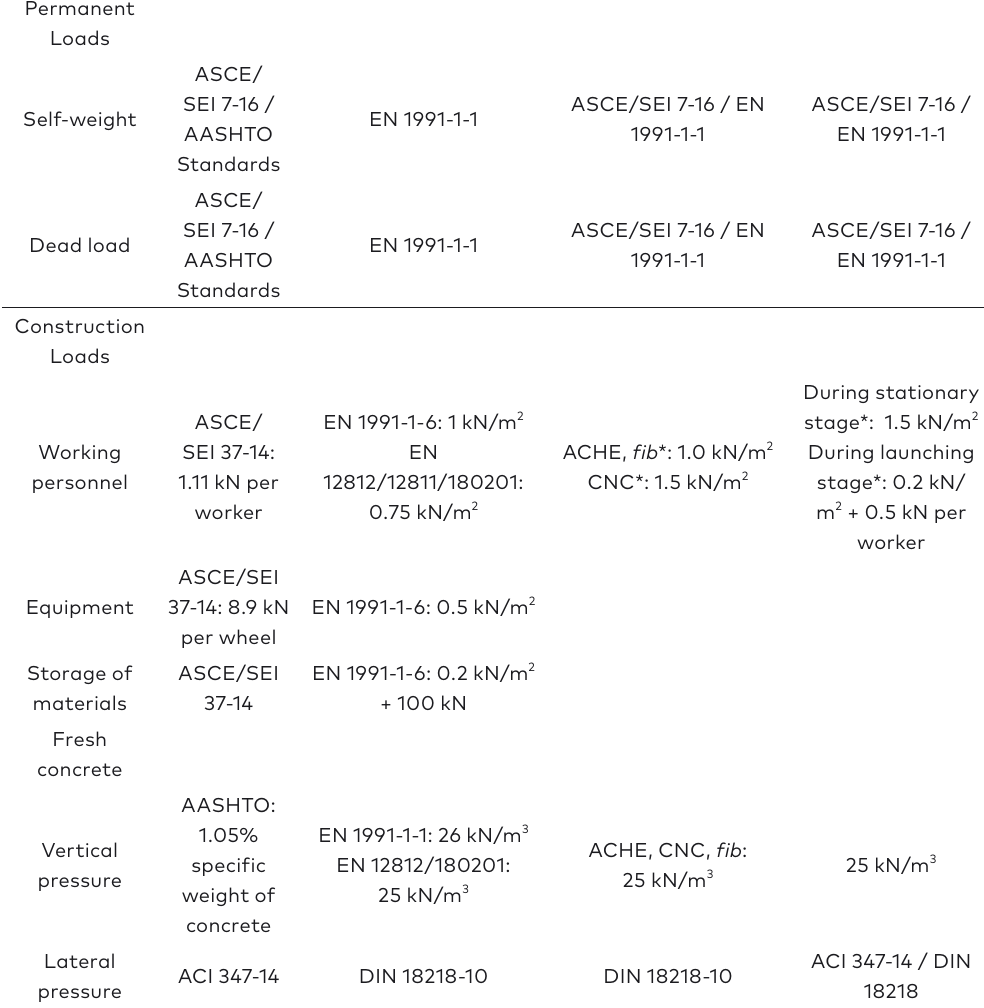
recommendations